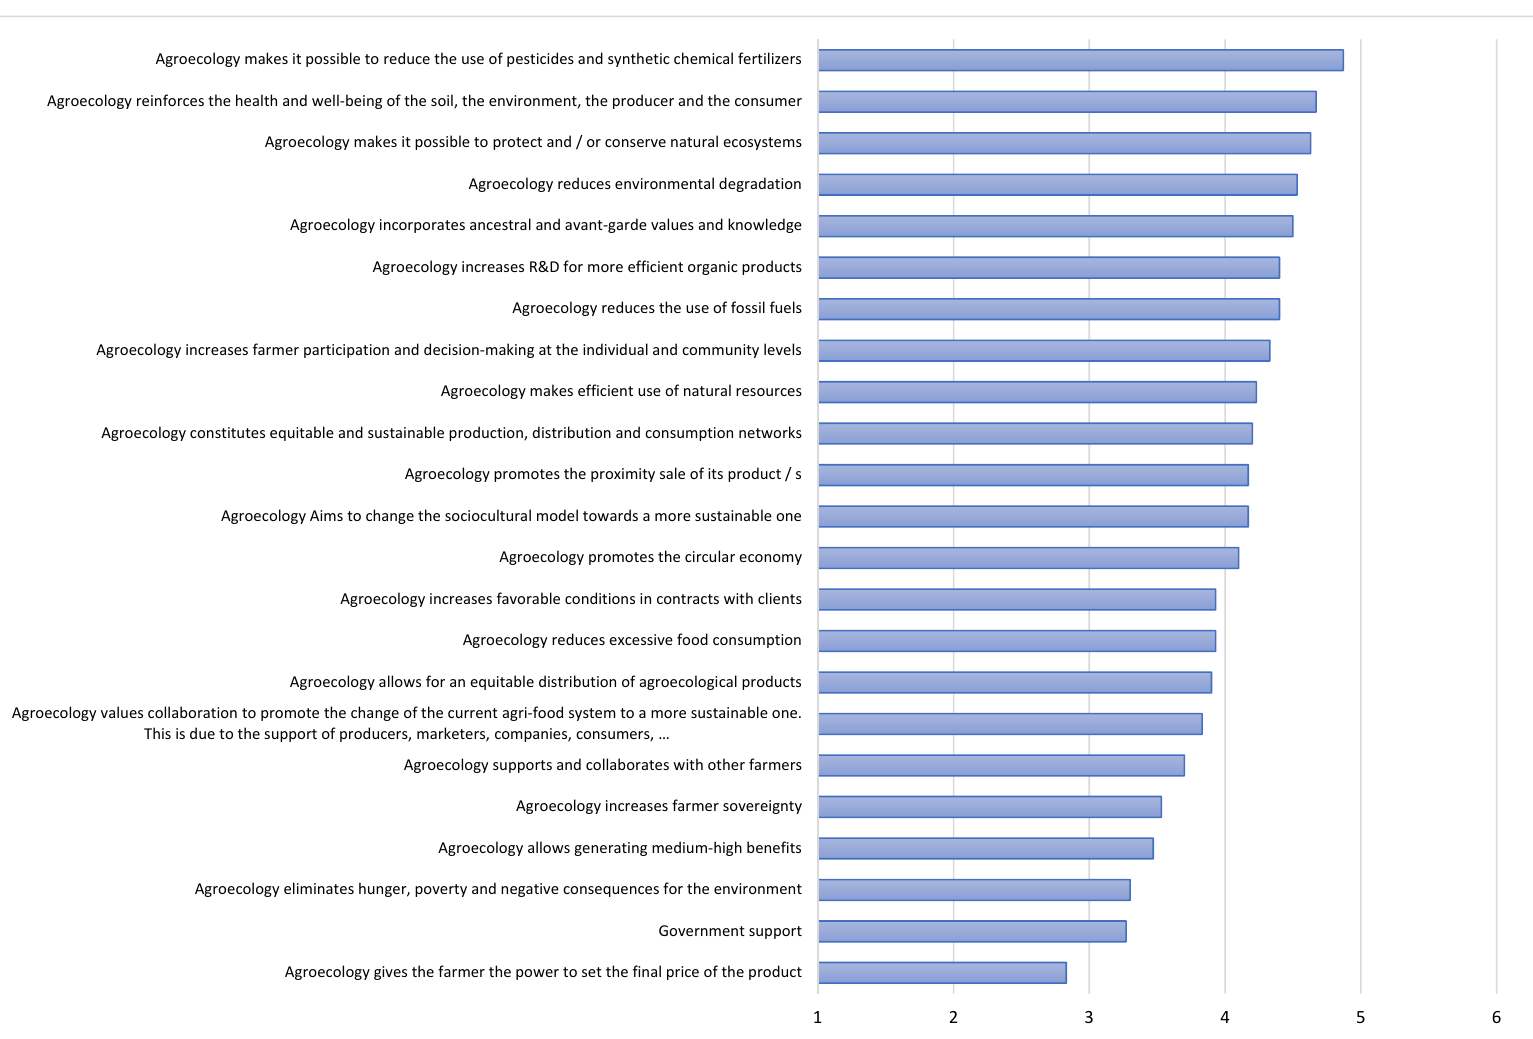
Figure 7. Scalar average according to the assessment of some statements related to agroecological